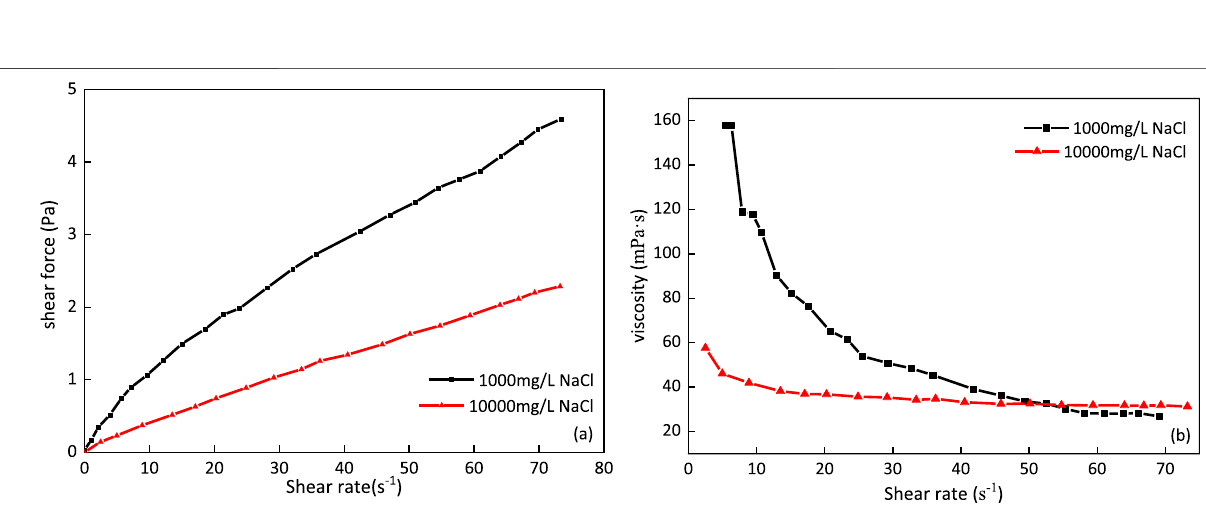
Frontiers in Chemistry |